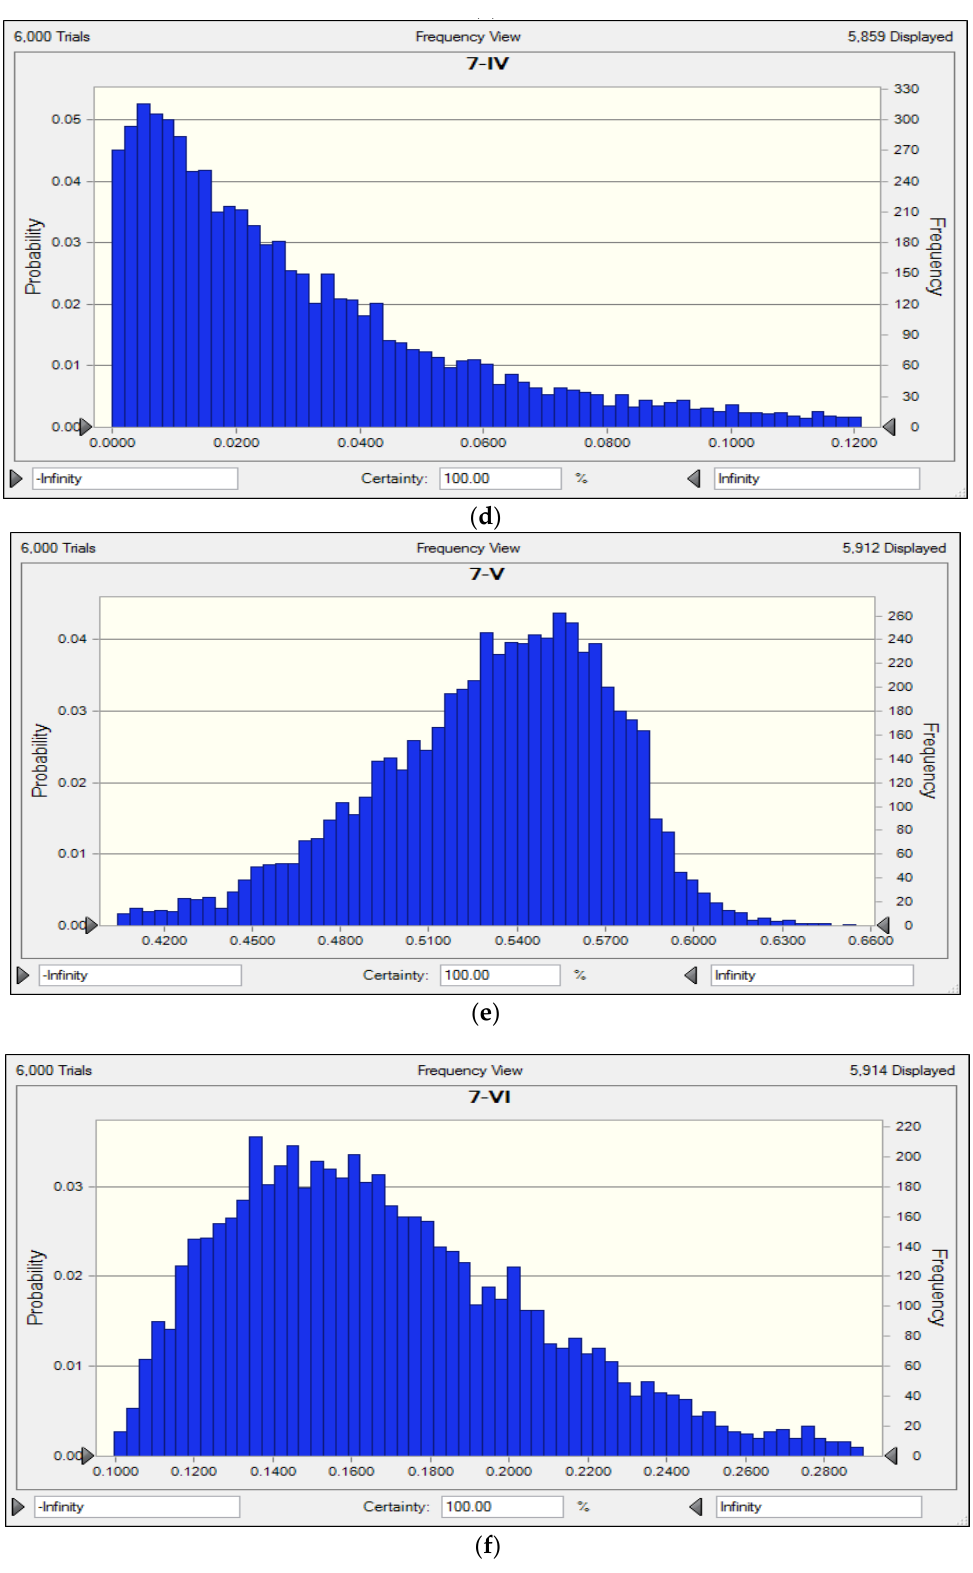
Figure 3. Results of certainty degrees to eutrophication level I, II, III, IV, V, and VI for Nansi Lake. ( a ) Distribution of certainty degree to level I for Nansi Lake (S7); ( b ) Distribution of certainty degree to level II for Nansi Lake (S7); ( c ) Distribution of certainty degree to level III for Nansi Lake (S7); ( d ) Distribution of certainty degree to level IV for Nansi Lake (S7); ( e ) Distribution of certainty degree to level V for Nansi Lake (S7); ( f ) Distribution of certainty degree to level VI for Nansi Lake (S7). In the fuzzy matter element (FME) model, the fuzziness of eutrophication assessment process is considered. The distances between evaluated matter element and standard matter element are replaced with membership function in fuzzy set theory. The membership functions have multiple patterns including triangular function, trapezoidal function, and normal function. However, the randomness existed in evaluation process was not considered. In the CME model, the membership degrees are replaced by certainty degree with three parameters E x , E n , and H e with consideration of randomness. For example, for Gaoshan Lake (S2), Gucheng Lake (S6), Dali Lake (S9), and Dongshan Lake (S17), the eutrophication evaluation results of FME model and CME model were consistent completely, which are level III, IV, V, and VI, respectively. The maximum fuzzy correlation coefficients obtained by the FME model were definite, which were 0.583, 0.477, 0.511, and 0.842 for S2, S6, S9, and S17, respectively. However, the distributions of certainty degree can be obtained by the CME model (shown in Figure 4). ( a )